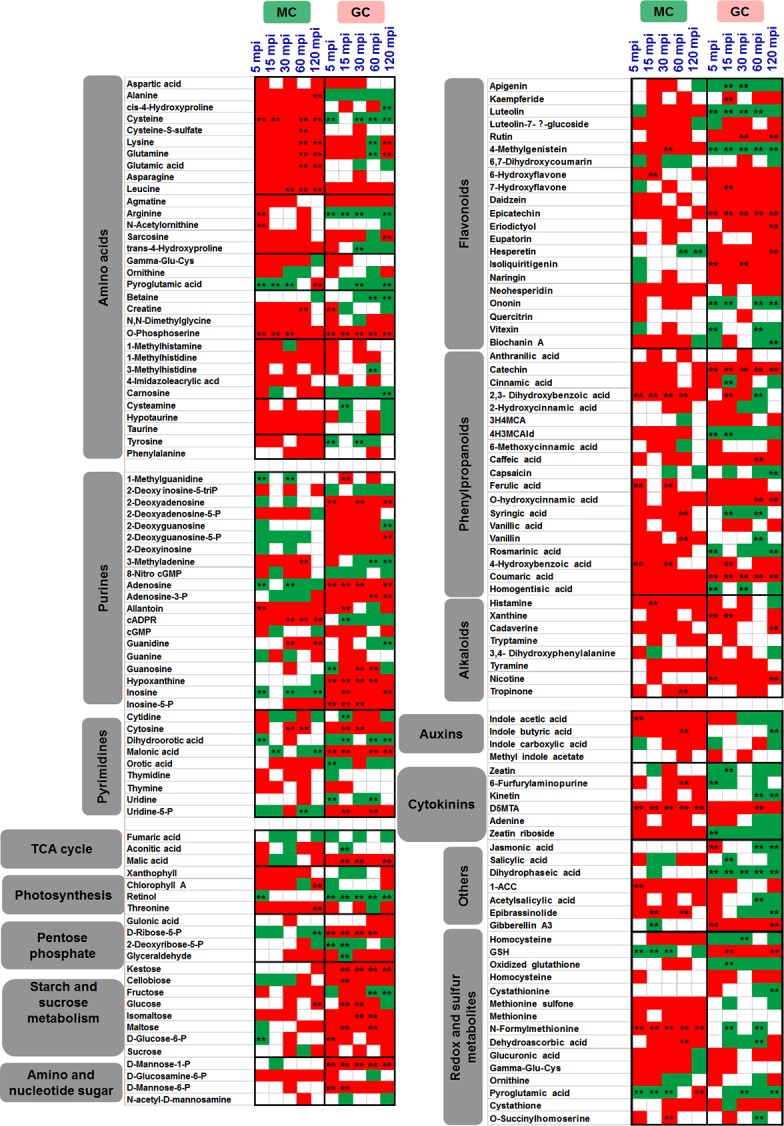
Responses of major metabolite groups in MCs and GCs upon HCO3
- treatment in the time-course study.Green and red squares indicate decreased (<0.8) and increased (>1.2) fold changes, respectively. The asterisks indicate significant changes (P <0.05).